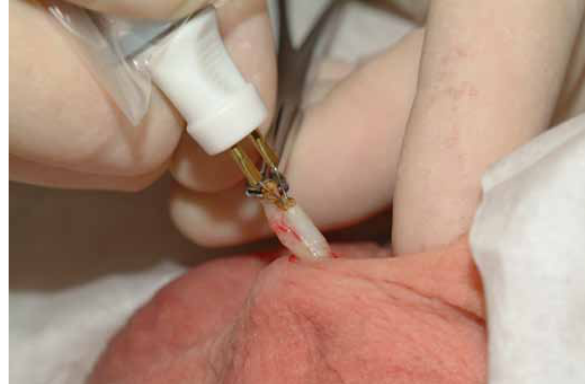
Figure 6 - Grasping the internal spermatic fascia with dissecting forceps.